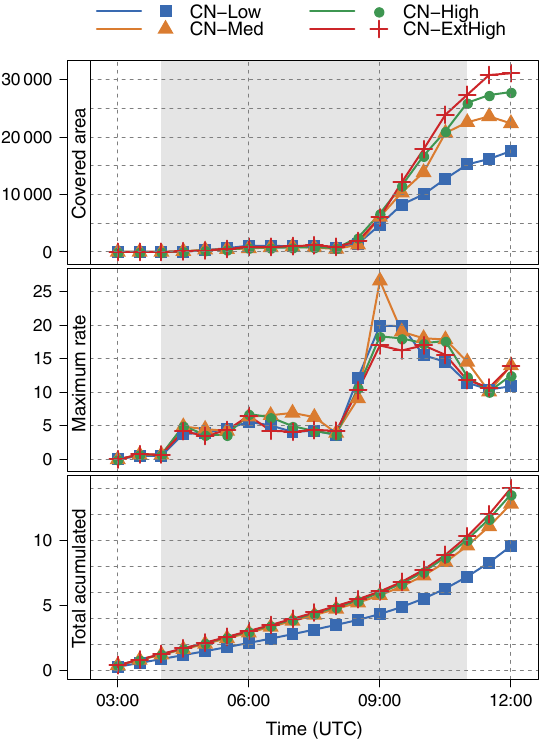
Figure 7. Precipitation covered area (km 2 ), maximum precipitation rate (mmh − 1 ) and total accumulated precipitation (1 × 10 5 mm) as a function of time for the CN-Low (blue), CN-Med (marigold), CN- High (green) and CN-ExtHigh (red) experiments. The shaded area in grey represents the time period that the entire MCS is within the grid domain.